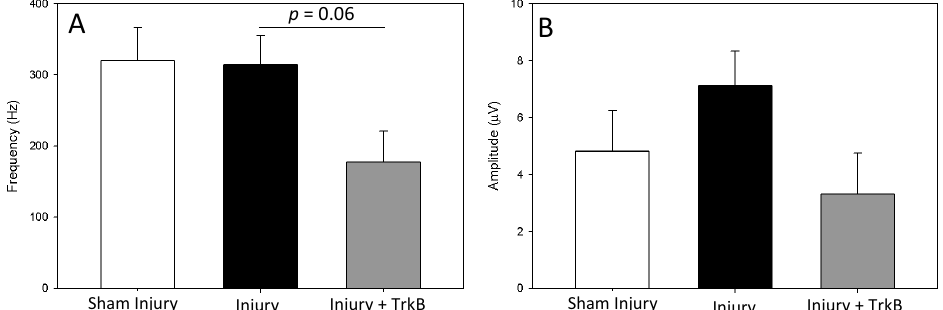
Figure 3. External urethral sphincter electromyography results. External urethral sphincter (EUS) electromyography (EMG) firing rate ( A ) and amplitude ( B ) 6 weeks after sham injury treated with saline (Sham Injury), pudendal nerve crush (PNC) and vaginal distension (VD) injury treated with saline (Injury), or PNC + VD injury treated with tyrosine kinase B (TrkB) fusion-chimera (Injury + TrkB). Each bar represents mean ± standard error of the data from 11–14 animals. There were 4–6 EUS EMG tests per animal. A Welsh one-way analysis of variance (ANOVA) with a Dunnett’s T3 post hoc test was used to determine statistically significant differences ( p < 0.05) compared to the Injury group.